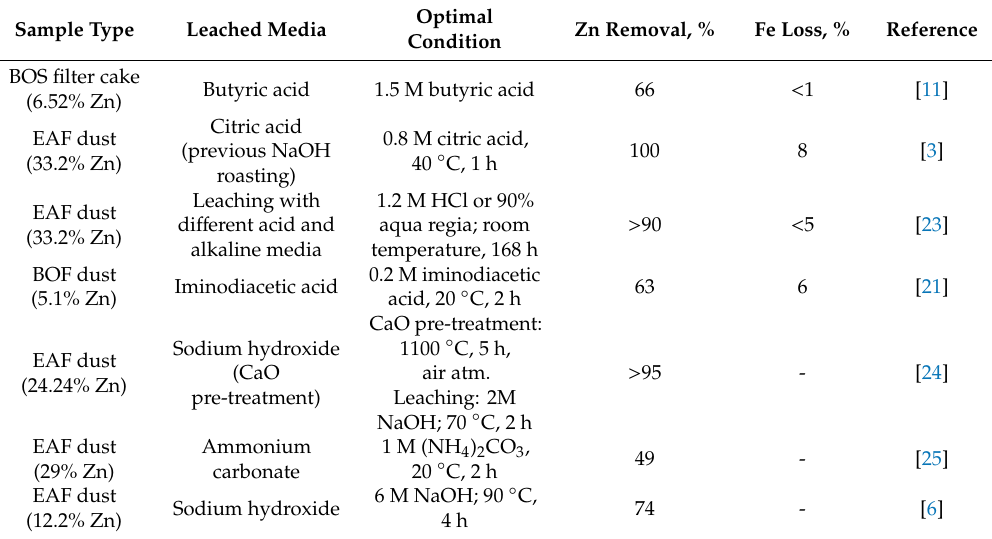
Table 2. Leaching studies for Zn removal using di ff erent aqueous